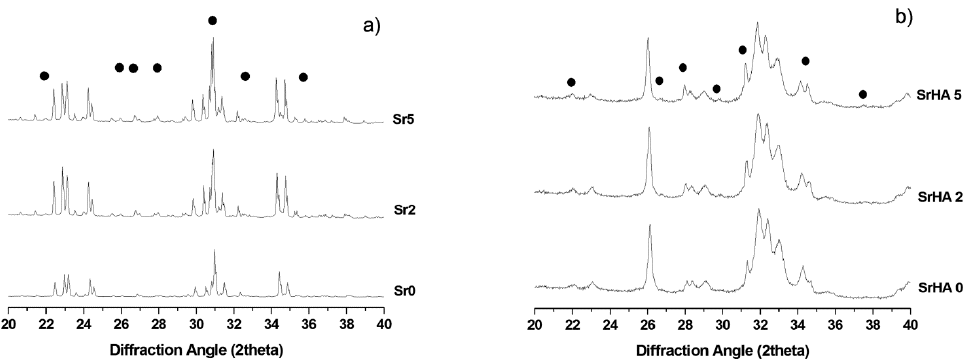
Figure 1. XRD diffraction profiles of: ( a ) cement precursors with different Sr content (Sr/Ca: 0–5 mol %); ( b ) the corresponding hardened cements after 3 days of incubation at 37 °C. The • symbol indicates the peaks belonging to β TCP phase. In Figure 1a the non-indexed peaks address α TCP phase, whereas in Figure 1b, the HA phase.